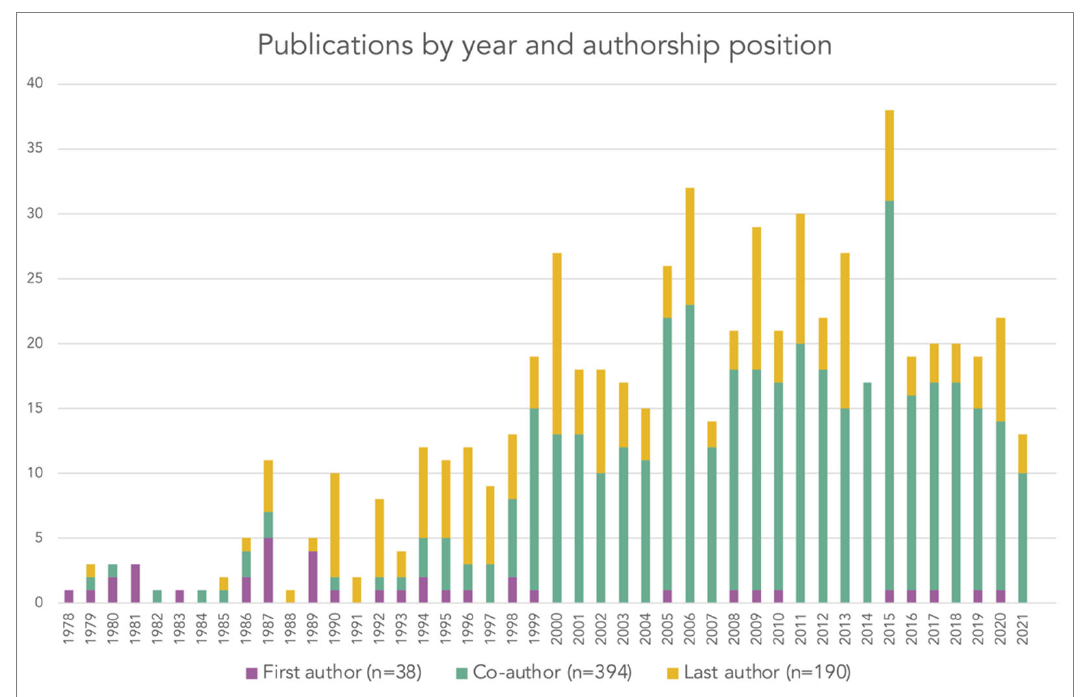
Figure 2. Yearly number of peer-reviewed articles co-authored by Marcel Tanner from 1978 to 2021, stratified by first, co-, and last author (source: Web of Science Core Collection, search performed on 3 August 2022).